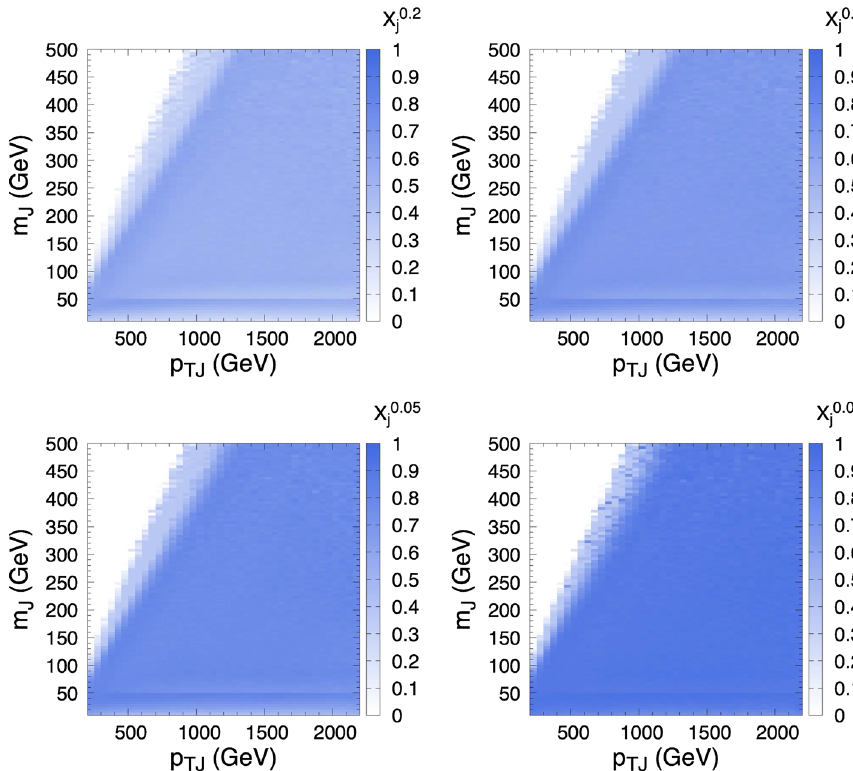
Fig. 7 Thresholds for in-situ mass decorrelation computed in bins of jet mass and p T for four fixed efficiencies ε b = 0 . 2, 0.1, 0.05, 0.01 from left to right and top to bottom. Empty bins on the upper left side of the plots are shown in